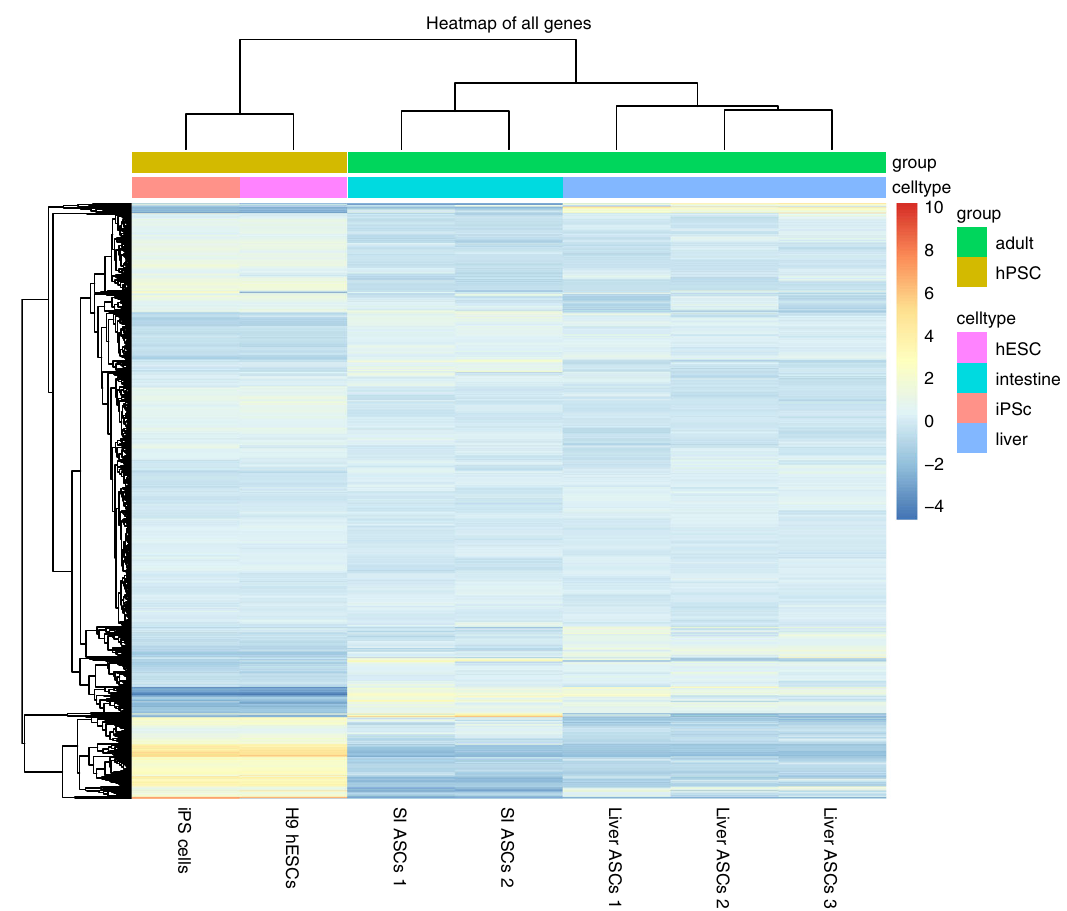
Fig. 6 RNA-seq analysis of human adult and pluripotent stem cells. Heatmap and unsupervised hierarchical clustering of RNA-seq data for all genes for human PSCs, human ES cells, human liver stem cells, and human intestinal stem